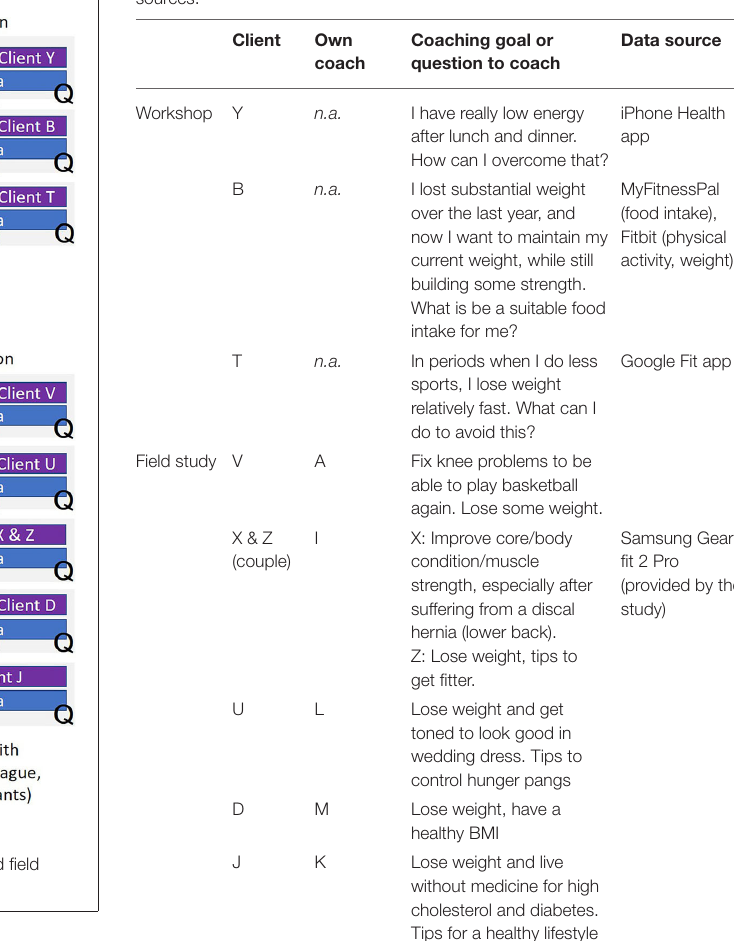
TABLE 1 | An overview of participating clients’ goals, questions, and data